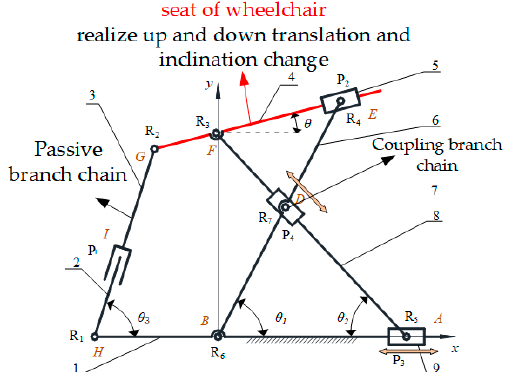
Figure 3. A planar two-degree-of-freedom (2-DOF) parallel mechanism with coupling branches: 1. link 1; 2. link 2; 3. link 3; 4. link 4; 5. slider 2; 6. link 5; 7. slider 3; 8. link 6; 9. slider 1. R 1 , R 2 , R 3 , R 4 ,